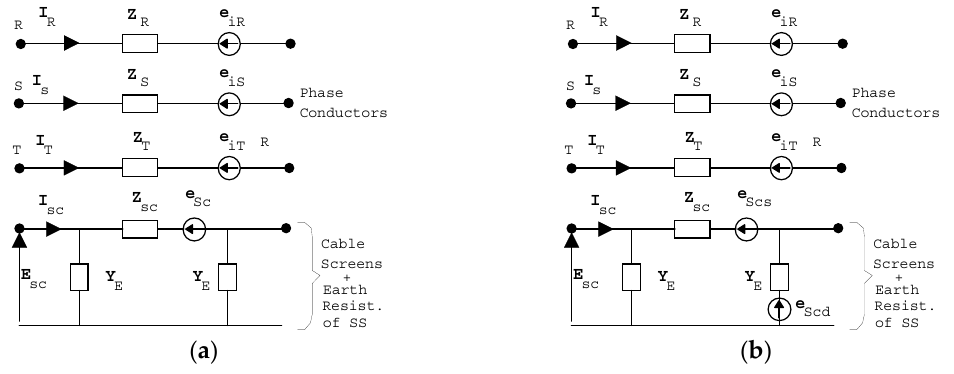
Figure 2. Equivalent circuit of a cable line stretch of length ‘ a ’ with phase conductors, screens, and earth resistance of secondary substation (SS).